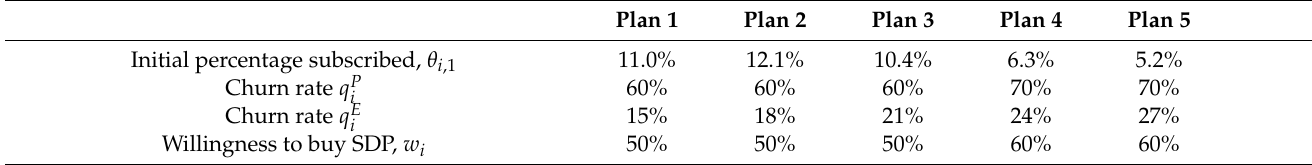
Table 4. Base case: parameters related to the data plans and supplementary data packages.